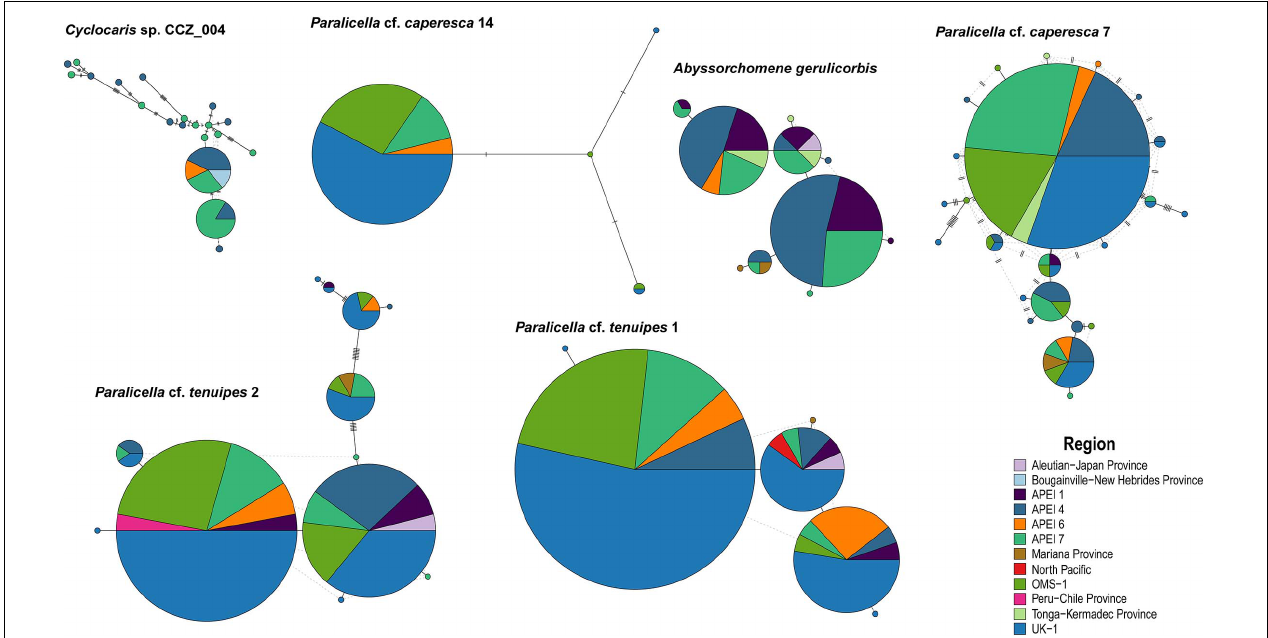
FIGURE 8 | Minimum-spanning tree haplotype networks for COI for six species of scavenging amphipods. Circles are proportional to the number of samples and all regions are color-coded.